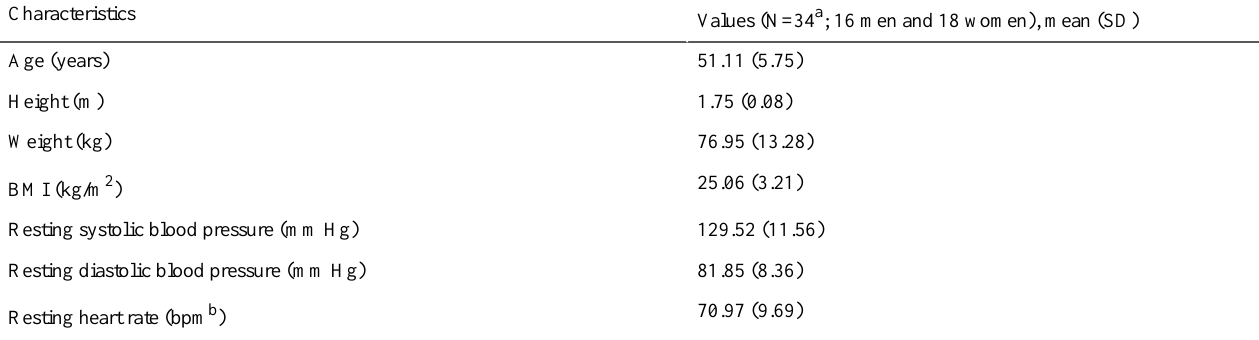
Table 1. Characteristics of the participants after excluding 3